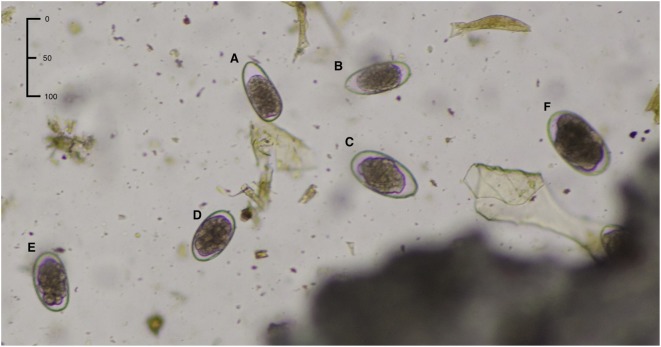
Morphological appearance of the strongylid eggs: (A,B)
Trichostrongylus axei, (C)
Teladorsagia circumcincta, (D)
Haemonchus contortus, (E) doubtful egg type (cannot be classified as Haemonchus), (F)
Chabertia/Oesophagostomum. Characteristics of H. contortus are length 70 ± 10 μm and width 45 ± 5 μm plus well-developed distinct blastomeres.